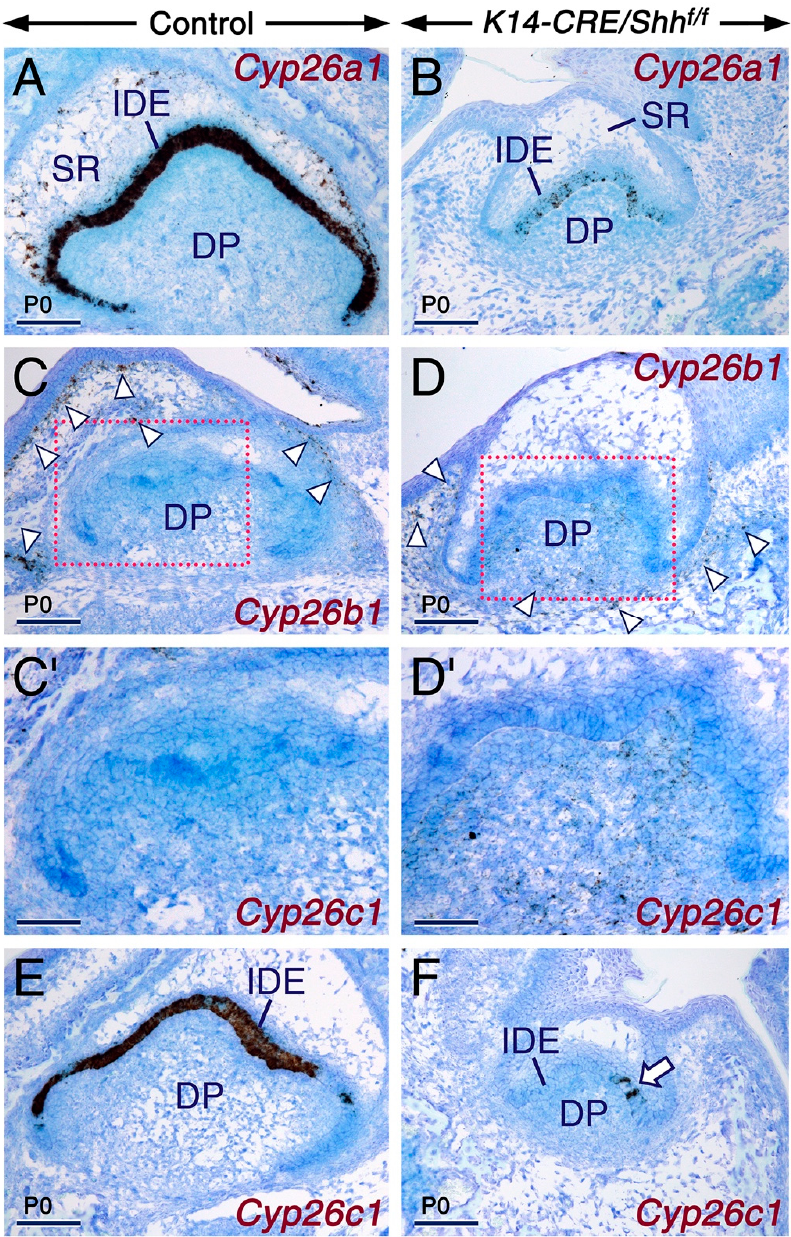
Figure 7. SHH signaling is required for maintenance of the expression of Cyp26a1 and Cyp26c1 in the developing tooth. ( A – F ). Representative Cyp26a1 ( A , B ; n = 2 controls and n = 2 mutants), Cyp26b1 ( C , D ; one control and one mutant) and Cyp26c1 ( E , F ; n = 2 controls and n = 2 mutants) in situ hybridization (black) with oligonucleotide probes in frontal sections across developing first molars from control ( A , C , E ) and K14-CRE / Shh f / f mutant ( B , D , F ) newborn (P0) mice. C’ and D’ are magnified views of the boxed areas in C and D , respectively. The mutant molars show severely diminished Cyp26a1 hybridization signals in the inner dental epithelium (IDE) and abolished Cyp26a1 expression